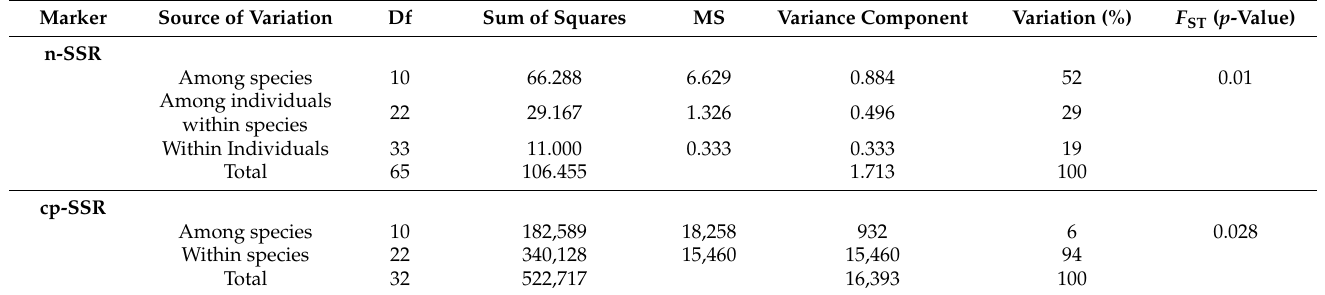
Table 4. Analysis of genetic differentiation between the 11 Medicago species by AMOVA with cp-SSR and n-SSR markers. df, degrees of freedom; MS, Mean squares; F ST , fixation